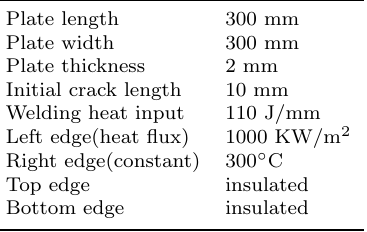
Table 1. Dimensions and boundary condition of the plate. Plate length